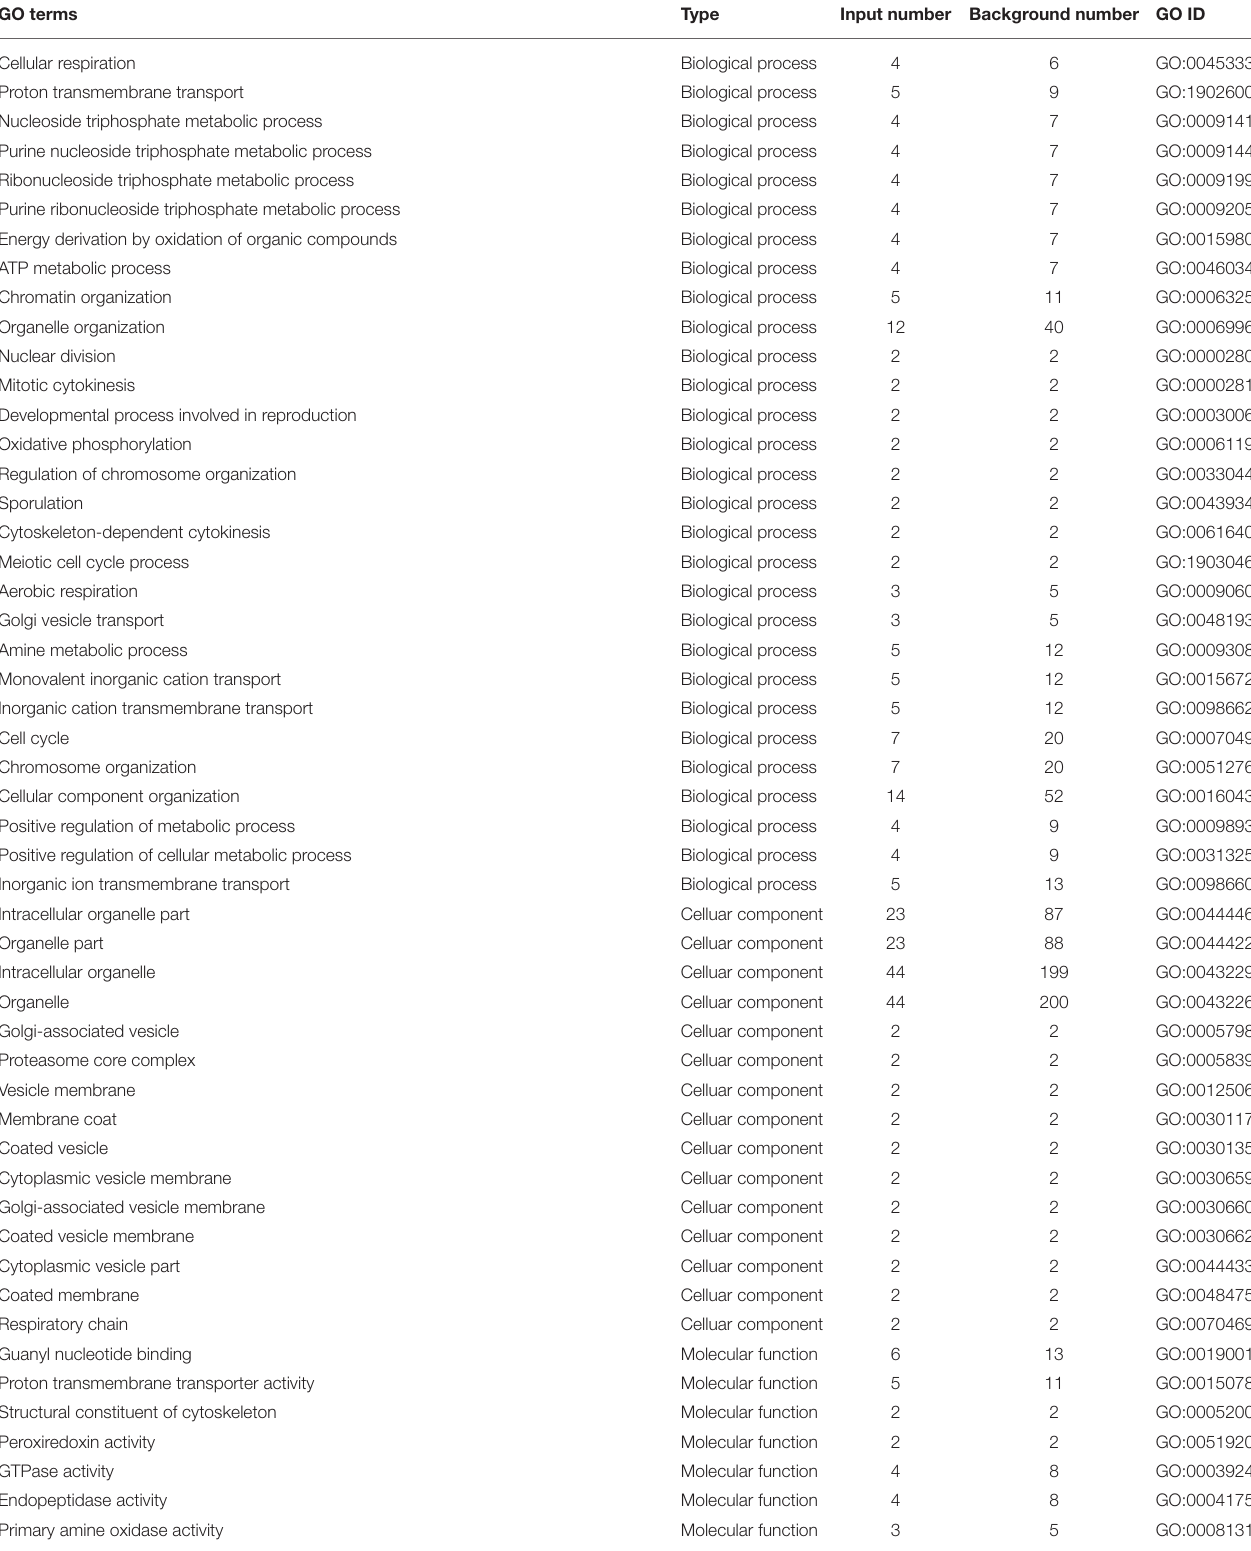
TABLE 4 | Mostly enriched GO terms of DEGs in P. digitatum